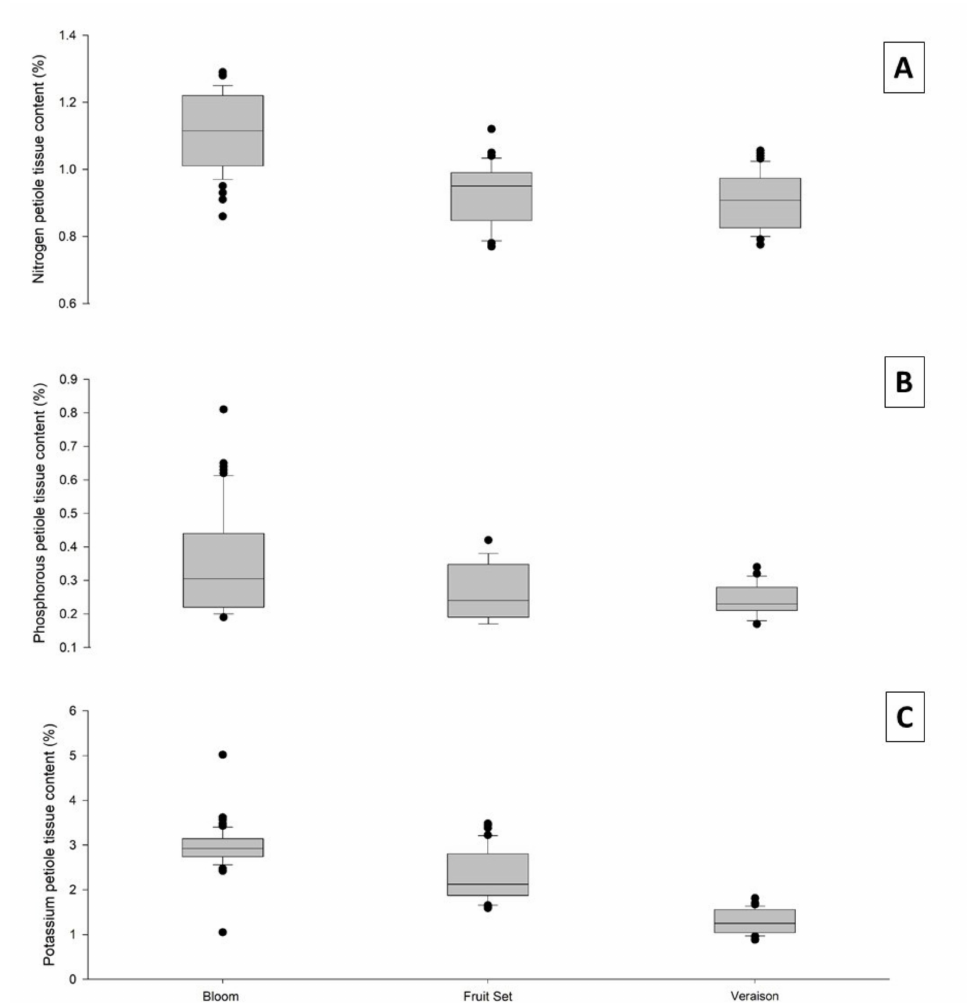
Figure 3. Variation of tissue nutrient content for nitrogen ( A ), phosphorous ( B ) and potassium ( C ) in petiole samples (combined data from 2019 and 2020, n = 56). Shown are Median, 25 and 75 percentiles as well as outliers. Samples taken during bloom show the highest variability, compared to samples taken at fruit set or v é